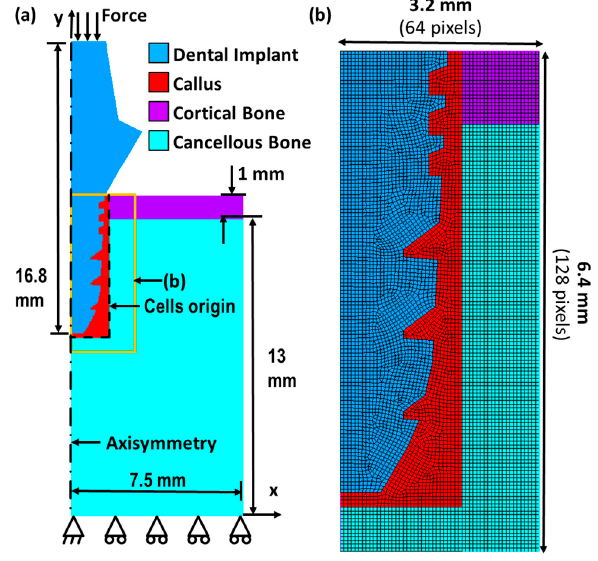
Figure 9. The schematic diagrams of ( a ) the FE model and ( b ) the cropped domain for the DLN training and testing.